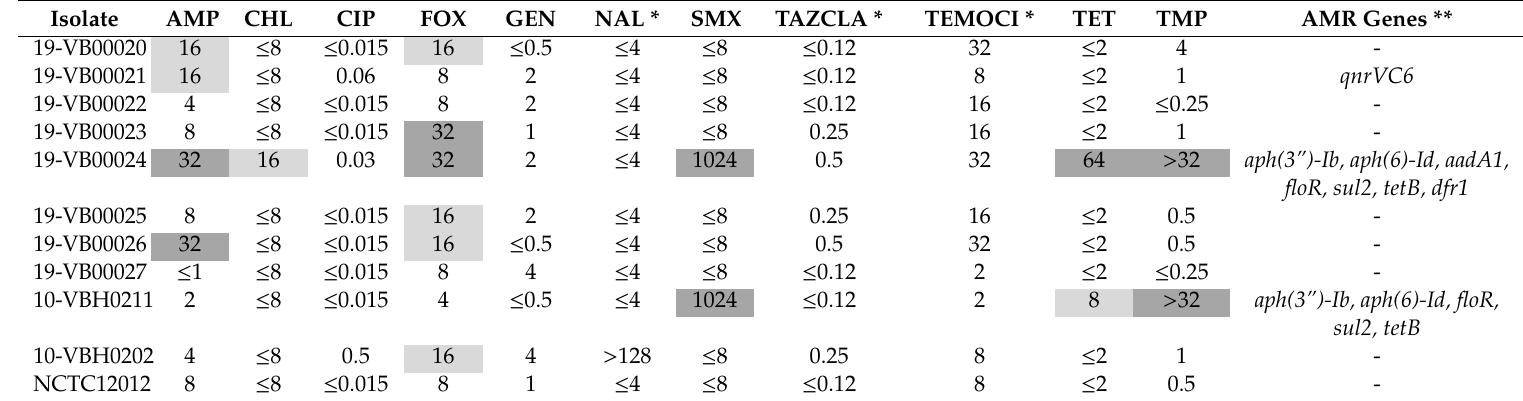
Table 3. Phenotypic and genotypic results of antimicrobial resistance of V. cincinnatiensis